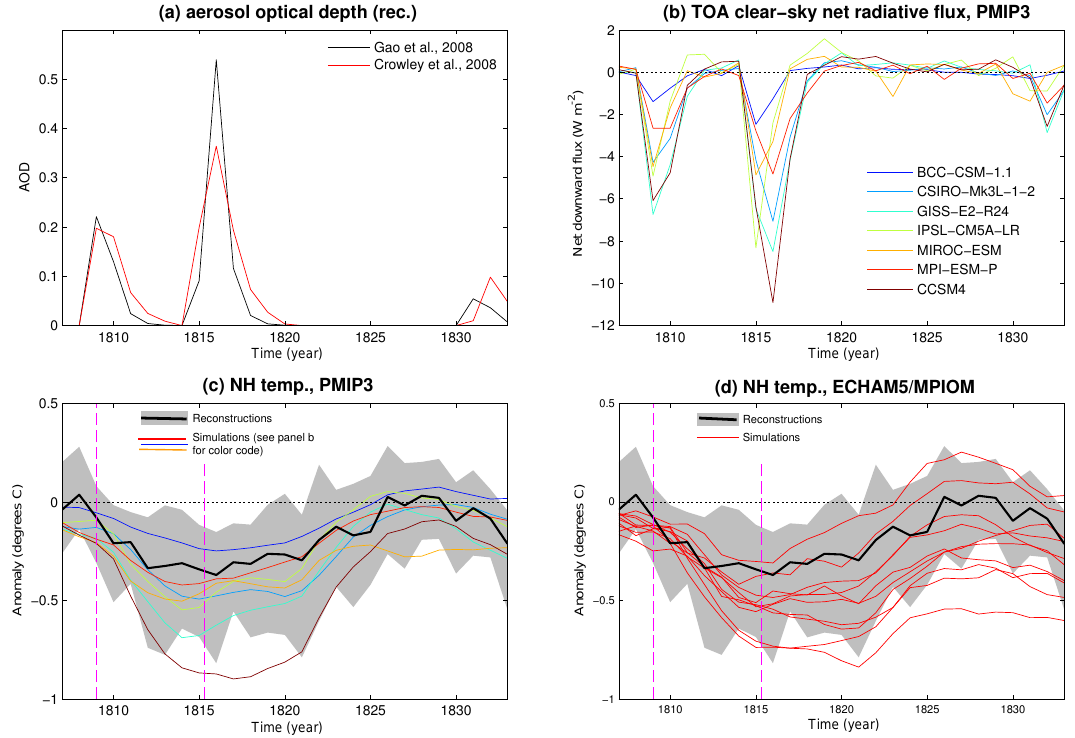
Figure 1. Uncertainty in radiative forcing and climatic response for the early-19th-century eruptions. (a) Two estimates of annual-average global aerosol optical depth (AOD) at 550nm; (b) top-of-atmosphere annual-average net clear-sky radiative flux anomalies for a multi-model ensemble of last-millennium simulations (PMIP3; see: Braconnot et al., 2012); (c) comparison between simulated (PMIP3, 11-year smooth- ing, colors) and reconstructed (black line: mean; shading: 5th–95th percentile range) Northern Hemisphere average summer temperature anomalies (relative to 1799–1808); (d) same as (c) but for a pre-PMIP3 single-model ensemble (ECHAM5/MPIOM; Zanchettin et al., 2013a, b). Reconstructed data are the full raw calibration ensemble by Frank et al.